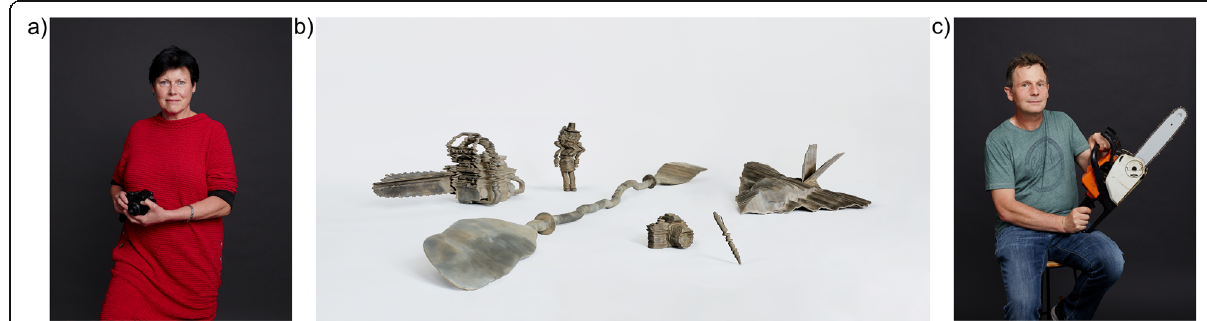
Fig. 1 Printed by Parkinson ’ s – design and patients ’ personal stories. Patients selected different objects representing their experience with PD: a a camera symbolizes difficulties and reacquisition of creative expression for this patient; c for the passionate former motorcyclist, using the chainsaw for handicraft and gardening is a favorite occupation beside rock-climbing, which he even started after the diagnosis. Individual electrophysiological data and selected objects were used to create unique bronze sculptures ( b ). Photographs were taken by Ender Suenni (photographer, Cosmopola